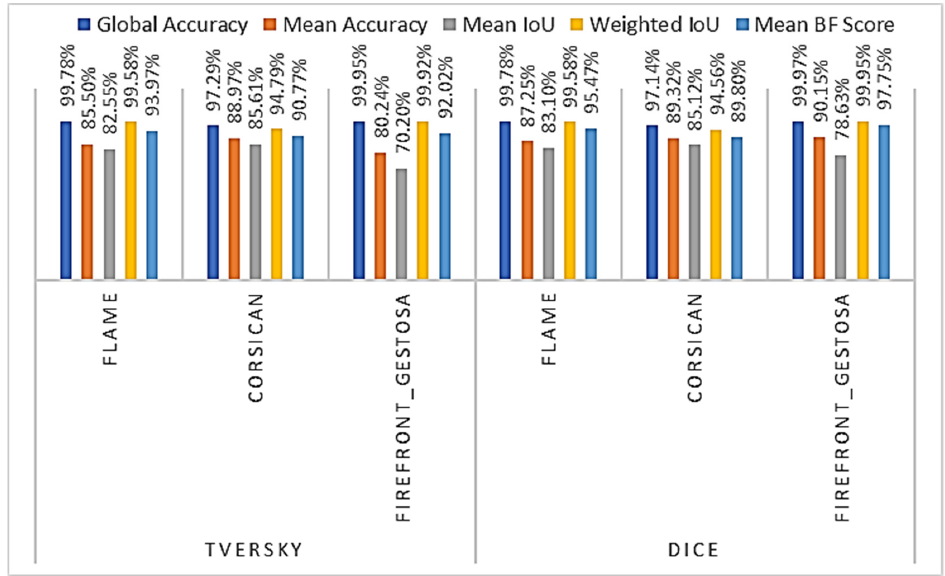
Figure 7. The overall metrics, over the three sets of data (FLAME, Corsican, and Firefront_Gestosa), gathered using Tversky and Dice loss functions with Deeplabv3+ with InceptionResNetV2 as backbone.